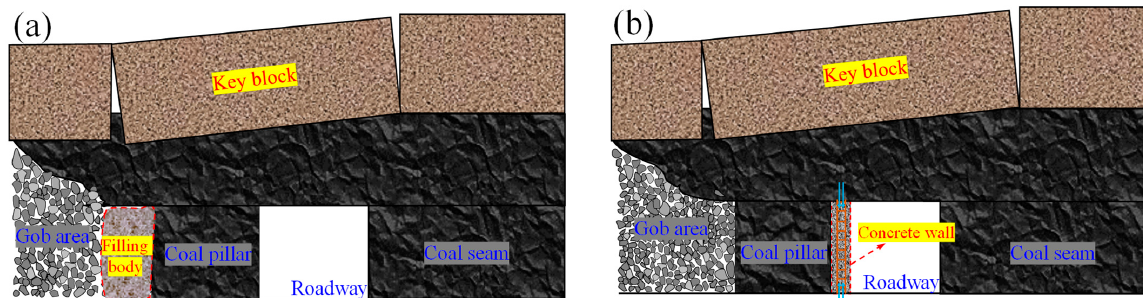
(c) Figure 23. Cont